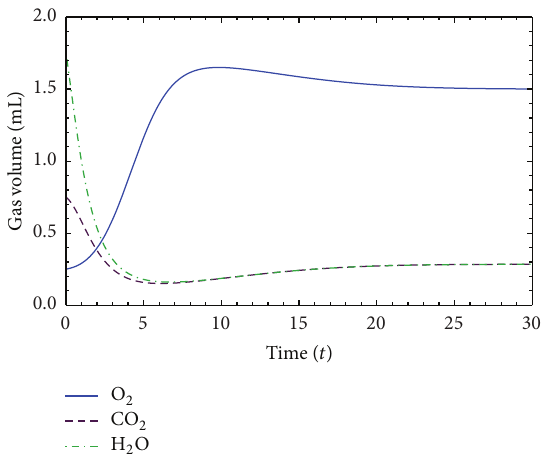
Figure 5: H 2 O profile in the beetle for varying values of 𝑒 . Here, all other parameter values are